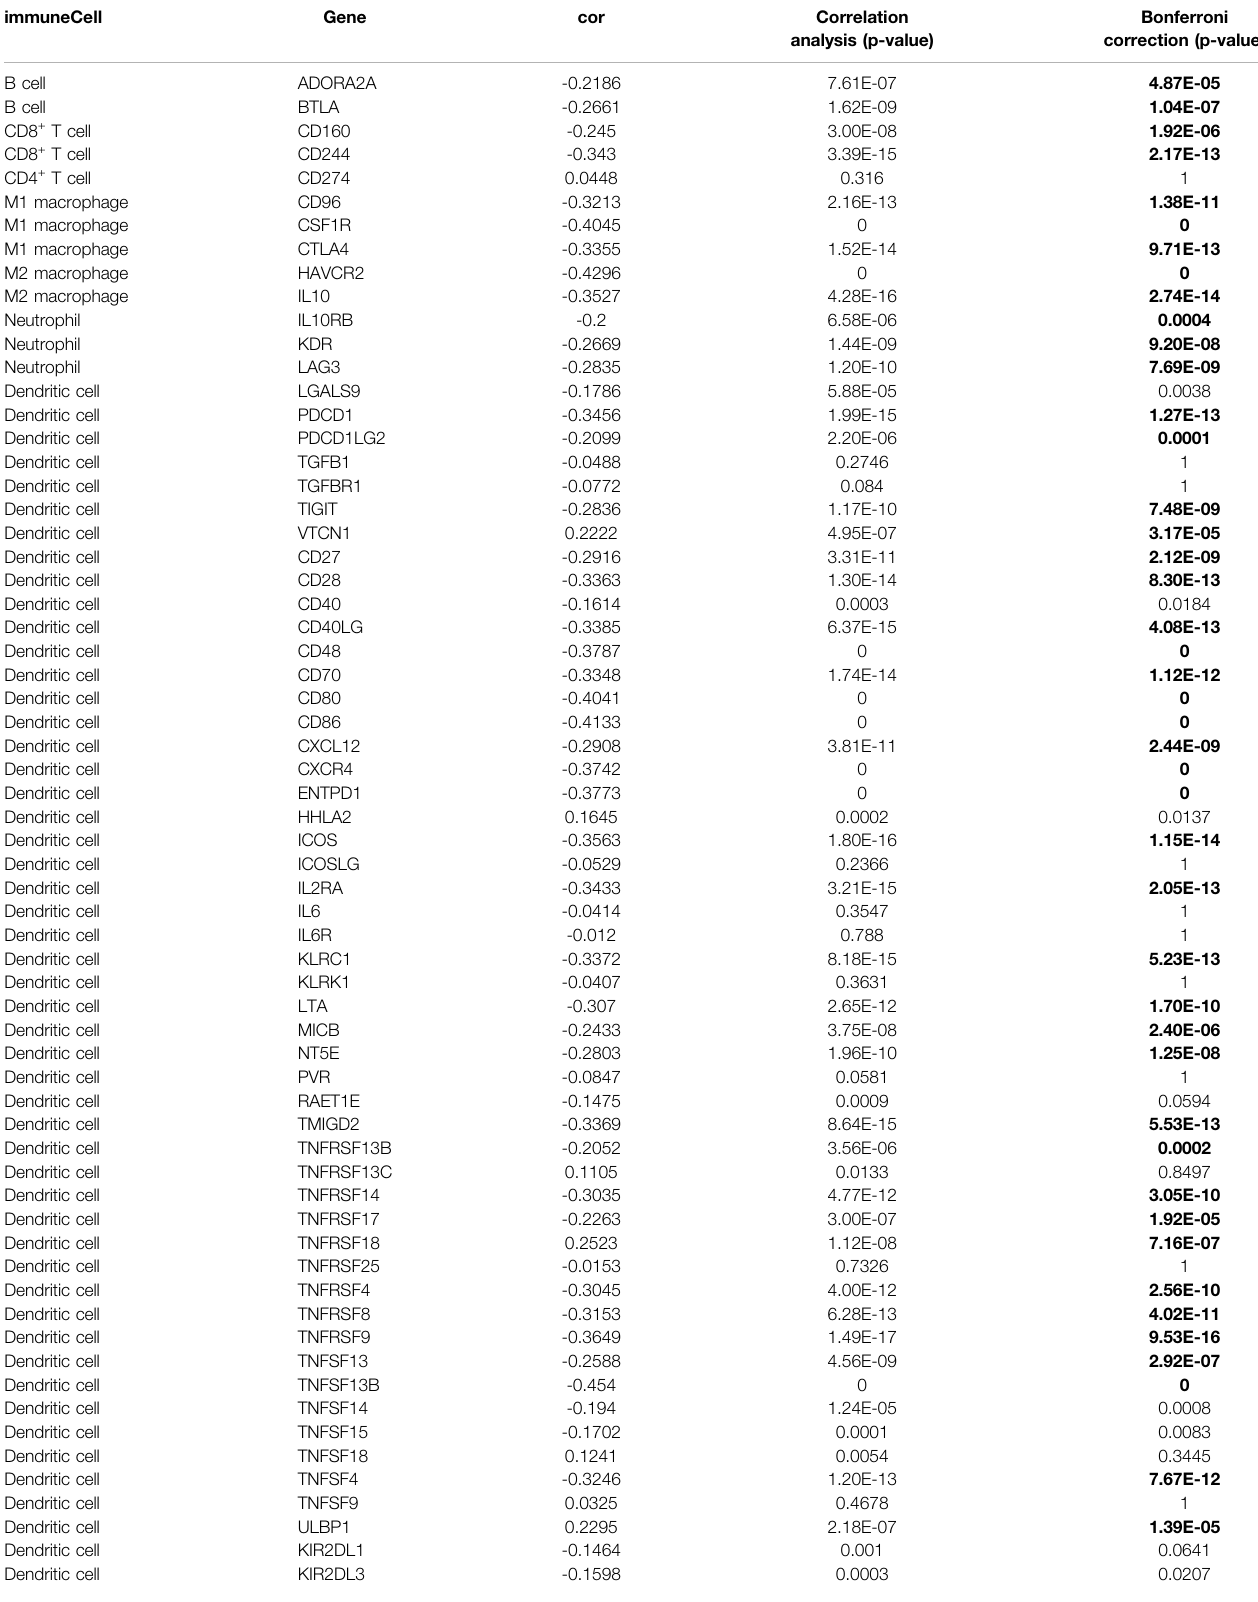
TABLE 3 | The correlations between expression of SLC6A8 and immunomodulators in LUAD.